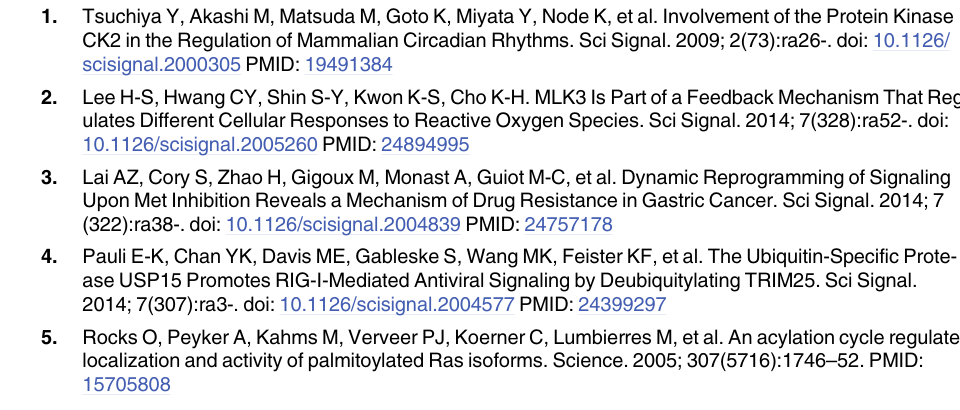
S4 Table. Stoichiometric matrix used for stochastic simulations. In the following table we define the stoichiometry and the directionality of the reactions of the model. Each reaction has a directionality that define which are the reagents and which are the products. In this table each line represents a model reaction, while in the columns we find all the states of the model. For each reaction the states of the model that take part to the reaction as reagents are marked with -1, while the states that participate as products are marked with 1. The matrix that is formed in this way allow to attribute the correct directionality to model reactions during the calculation of the mass balance for each state of the model. S5 Table. Propensity function used for stochastic simulations. In the first column of the table, each line describes a reaction of the model. To each reaction is associated a rate, in the second column, that describes the probability of that reaction to happen at each time step of the stochastic simulation. S6 Table. Parameters used for stochastic simulations. The following parameters were obtained through the conversion of the deterministic parameters estimated by the GA (see “ Conversion of deterministic parameters to stochastic ” ). S7 Table. Experimental data for Figs 1 and 2. Due to the small deviation that characterize the set of experimental data used for generating Figs 1 and 2, the error bars in those figures are not clearly visible. Therefore we report here the numeric data for those